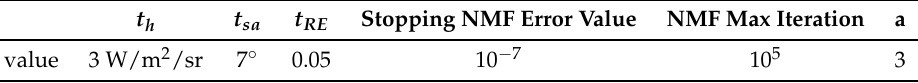
Table 3. HBEE-LSNMF parameter values for the synthetic data